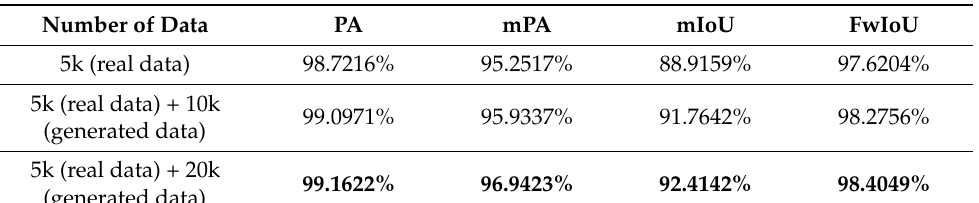
Table 2. The comparison of segmentation accuracy on the U-Net trained with different number of training images generated by the proposed image generation network.